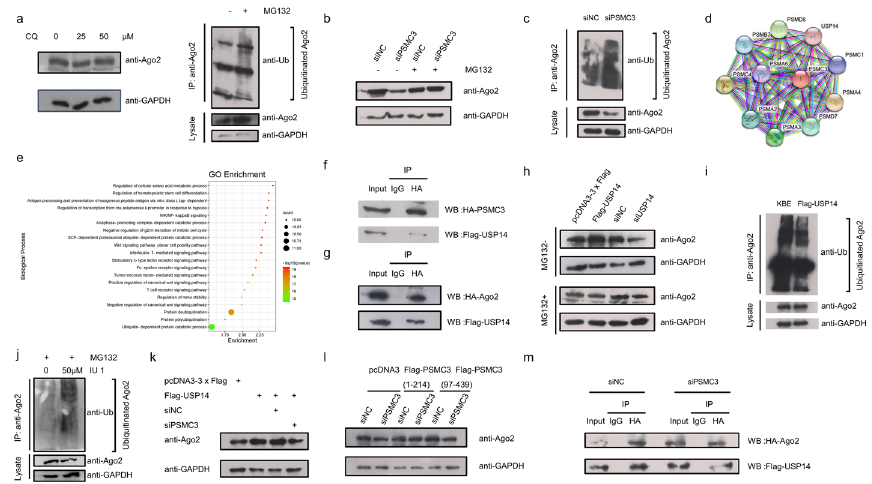
Fig. 5 Depletion of PSMC3 inhibits USP14 upregulation of AGO2 proteins. a AGO2 degradation via proteasome pathway. After Hela cells were treated with the indicated doses of chloroquine for 18 h, AGO2 protein levels were measured by western blotting assays (left). HeLa cells were incubated with the proteasome inhibitor MG132 (30 µM) or with DMSO for 10 h. Whole-cell lysates were immunoprecipitated with anti-AGO2 antibody and analyzed with anti-ubiquitin, anti-GAPDH, and anti-AGO2 antibodies (right). b , c Depletion of PSMC3 facilitates AGO2 ubiquitination. b HeLa cells were transfected with the indicated plasmids. After 36 h, cells were treated with or without 30 µM MG132 for 10 h. AGO2 protein levels were analyzed by western blotting assays. c HeLa cells were transfected with control or PSMC3 siRNAs. After 36 h, cells were incubated with MG132 (30 µM) for 10 h. Whole-cell lysates were immunoprecipitated with anti-AGO2 antibody and analyzed with anti-ubiquitin, anti-GAPDH, and anti-AGO2 antibodies. d The PPI network analysis of PSMC3 by the STRING database. e The top 20 biological process (BP) terms in the enrichment analysis of the PSMC3-interacting proteins. f , g PSMC3 ( f ) and AGO2 ( g ) both interact with USP14. HeLa cells were co-transfected with the indicated plasmids. Immunoprecipitation assays were performed with anti-HA antibody and western blotting with anti-Flag antibody. h , i AGO2 is deubiquitinated by USP14. h HeLa cells were transfected with the indicated plasmids. After 36 h, cells were treated with (bottom) or without (top) 30 µM MG132 for 10 h. AGO2 protein levels were analyzed by western blotting assays. i HeLa cells were transfected with the indicated plasmids. After 36 h, cells were incubated with MG132 (30 µM) for 10 h. Whole-cell lysates were immunoprecipitated with anti-AGO2 antibody and analyzed with anti-ubiquitin, anti-GAPDH, and anti-AGO2 antibodies. j HeLa cells were treated with or without IU1 (an inhibitor of the enzymatic activity of USP14) and MG132 (30 µM) for 10 h. Whole-cell lysates were immunoprecipitated with anti-AGO2 antibody and analyzed with anti-ubiquitin, anti-GAPDH, and anti-AGO2 antibodies. k Depletion of PSMC3 inhibits USP14 upregulation of AGO2 proteins. HeLa cells were transfected with the indicated plasmids and then AGO2 protein levels were analyzed by western blotting assays after 48 h. l HeLa cells were transfected with either the pcDNA3 vector only or the indicated Flag-tagged PSMC3 (1–214) and siRNA-resistant PSMC3 (97–439) mutant. At 24 h after transfection, cells were split into two aliquots and were retransfected with control or PSMC3 siRNA. Cell lysates were analyzed by western blotting with anti-AGO2 and anti-GAPDH antibodies. m The interaction between AGO2 and USP14 is diminished in PSMC3-depletion cells. HeLa cells were cotransfected with the indicated plasmids. Immunoprecipitation assays were performed with anti-HA antibody and western blotting with anti-Flag antibody. All results are representative of three independent